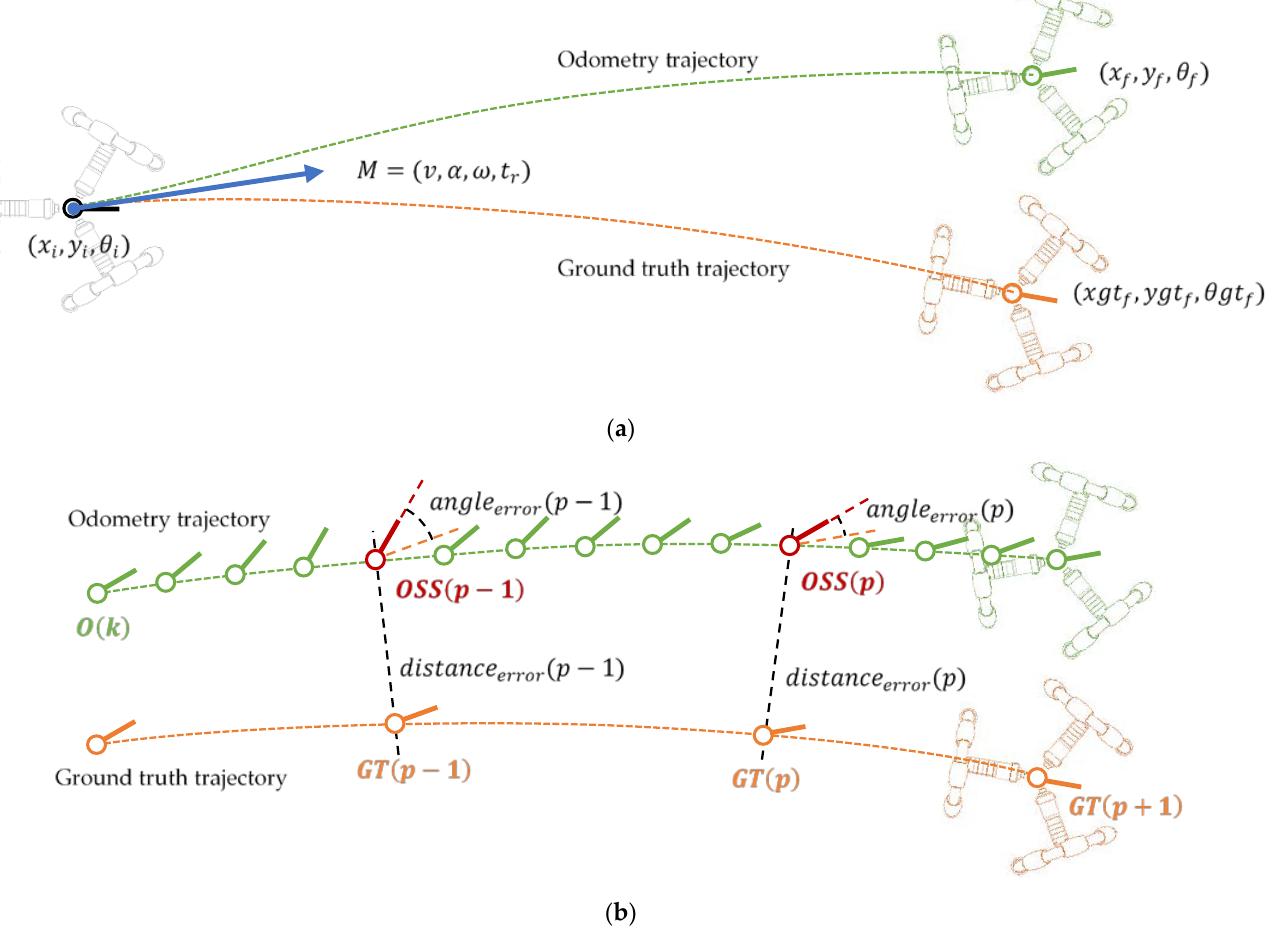
Figure 6. Representation of the ground truth trajectory of the mobile robot (orange line) and the trajectory estimated with the odometry (green line): ( a ) complete trajectories; ( b ) angle and distance differences between the trajectory positions estimated with the odometry and the SLAM procedure.